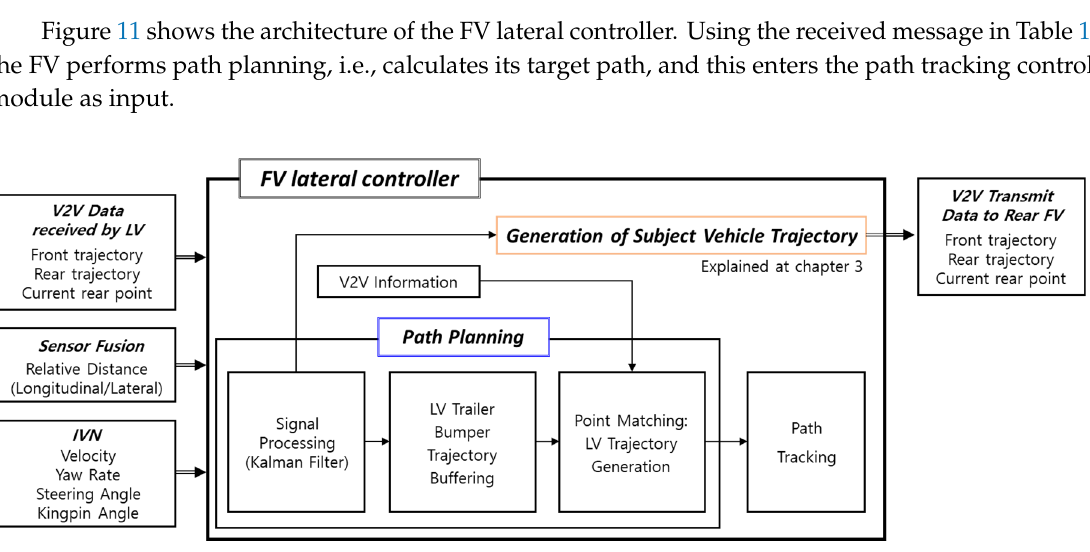
Table 1. The message that the leading vehicle (LV) sends to the following vehicle (FV) via V2V communication. Message coe ffi cients of 3rd order polynomial for LV’s “Front” trajectory coe ffi cients of 3rd order polynomial for LV’s “Rear” Trajectory coordinate of LV’s “Rear” point at the current sample